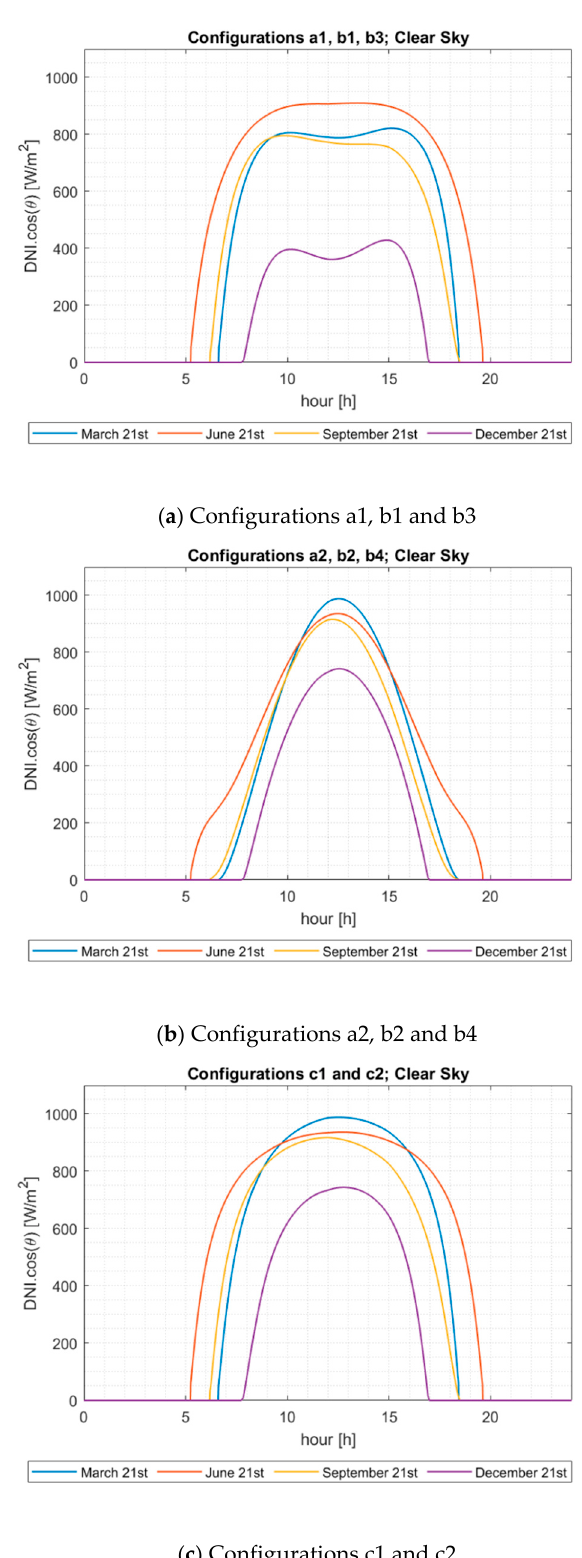
Figure A6. Intra-day variability on solstices and equinoxes of DNI.cos( θ ) in W/m 2 for all geometrical configurations listed in Table 5, under clear sky conditions, without applying PEC-PV tilt constraints. Site: Seville, Spain.